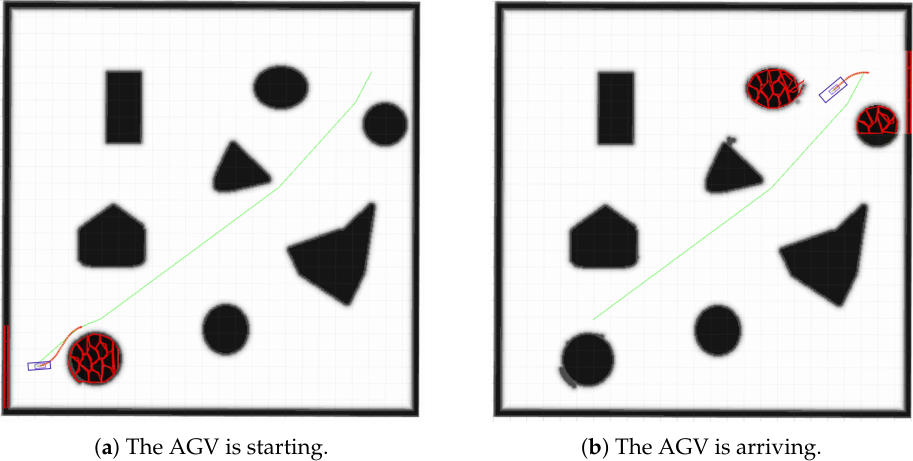
Figure 13. Illustration fused results of global path generating and local path planning in simulation static environment. Initial global path and optimized local trajectory are drawn in green and red to distinguish them. Blue mark presents the AGV, whose kinematic model has been described in Section